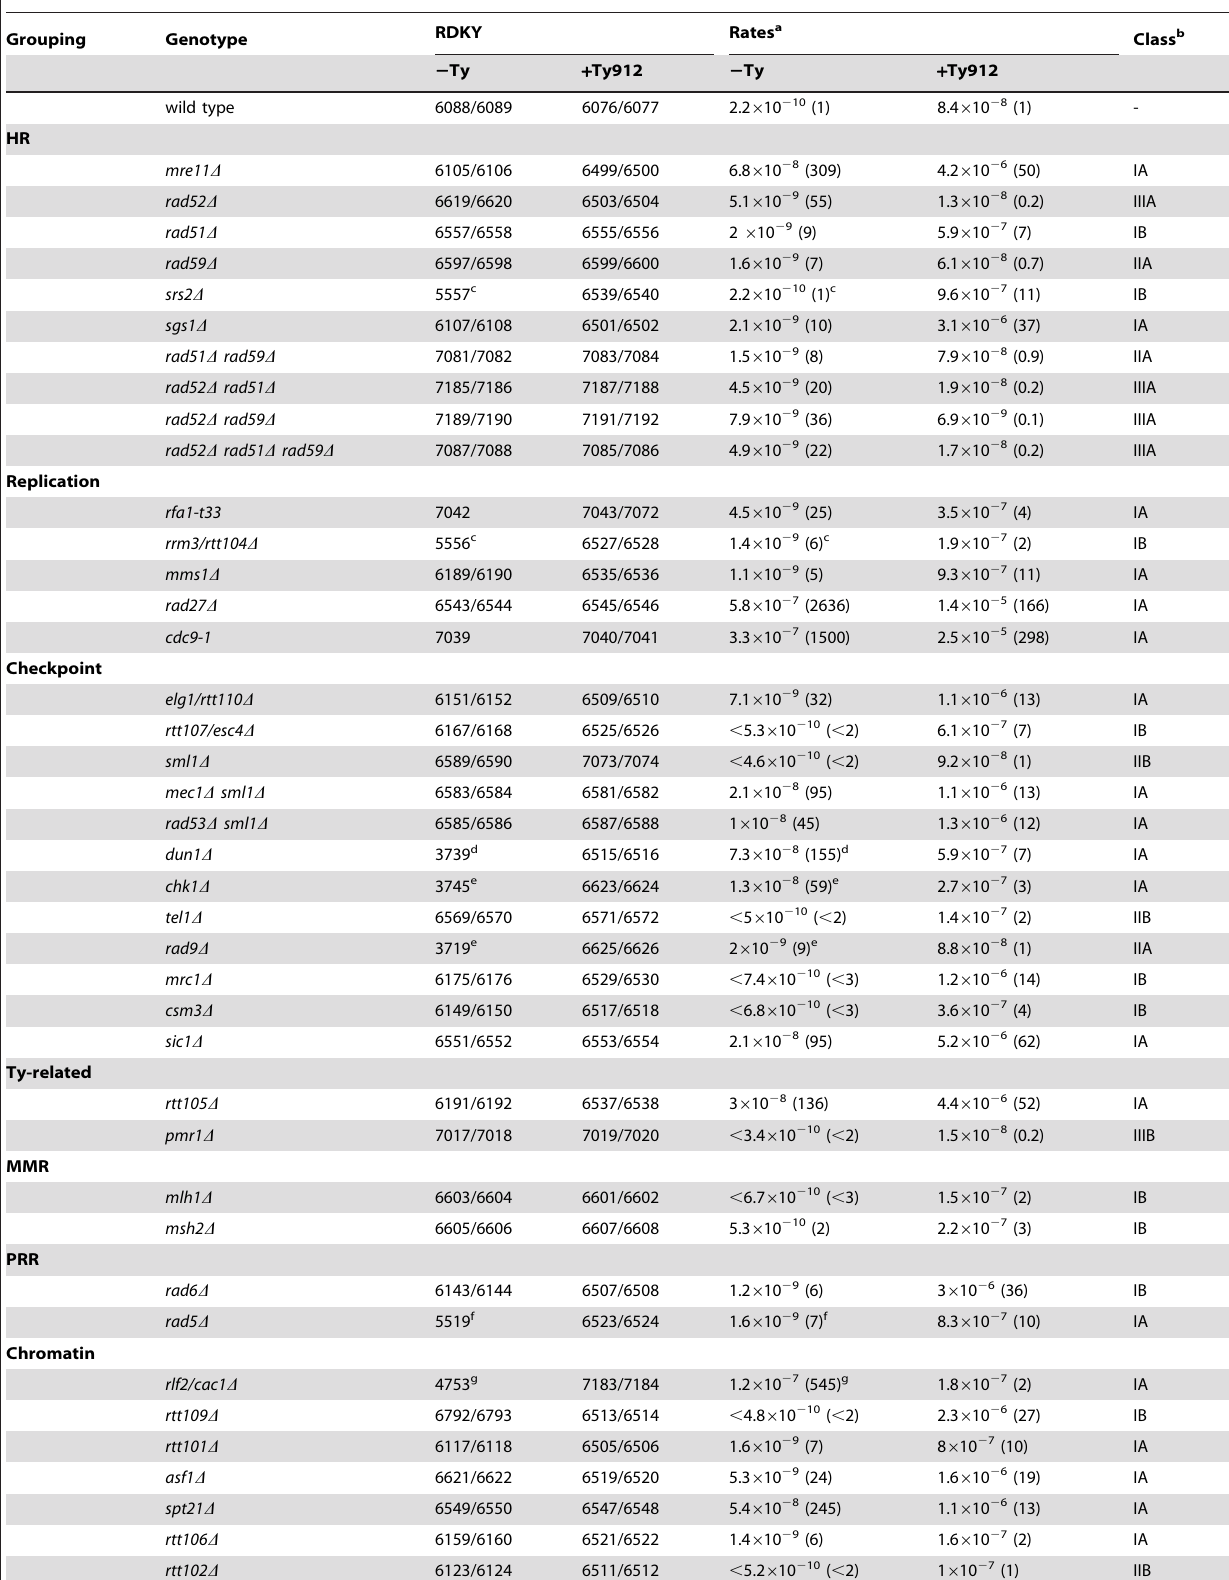
Table 1. Wild-type and mutant GCR